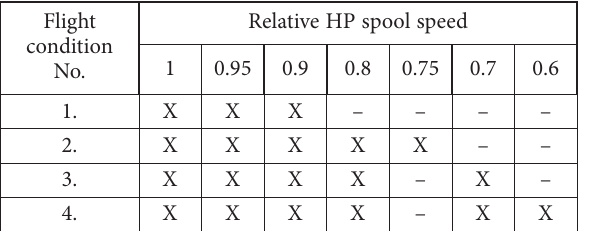
Table 3. Relative increase of the specific fuel consumption of